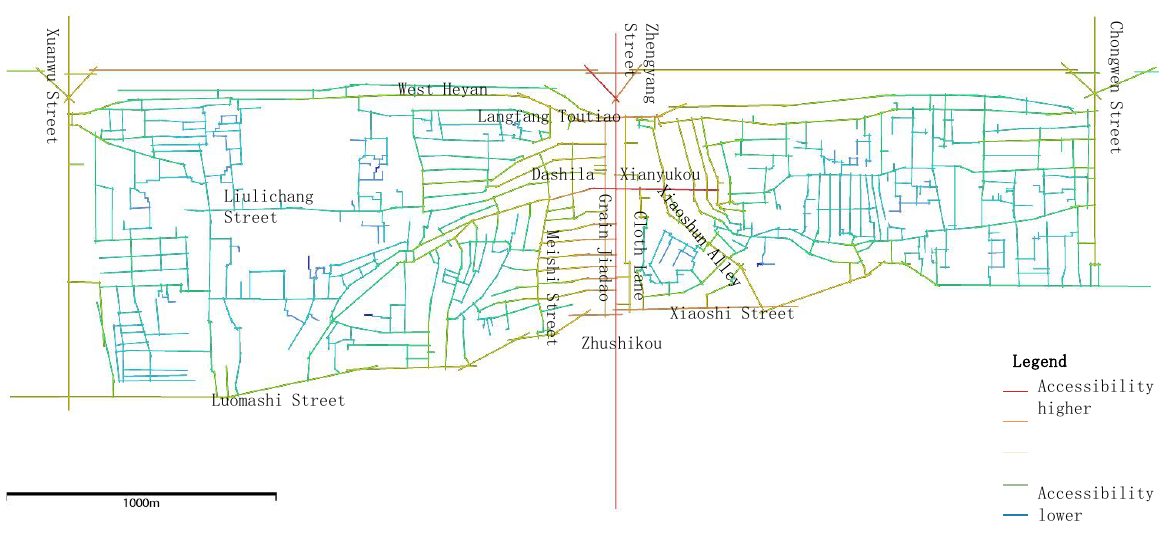
Figure 3. Integration of streets and alleys in Qianmen area during the Qianlong